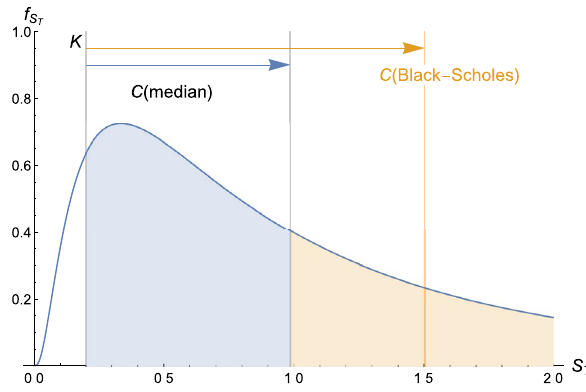
Fig. 2 The median C and the mean C BS (Black–Scholes). The prob- ability distribution of price S T ( S 0 = 1.5, 𝜎 = 1, T = 1, r = 0 and K = 0.2